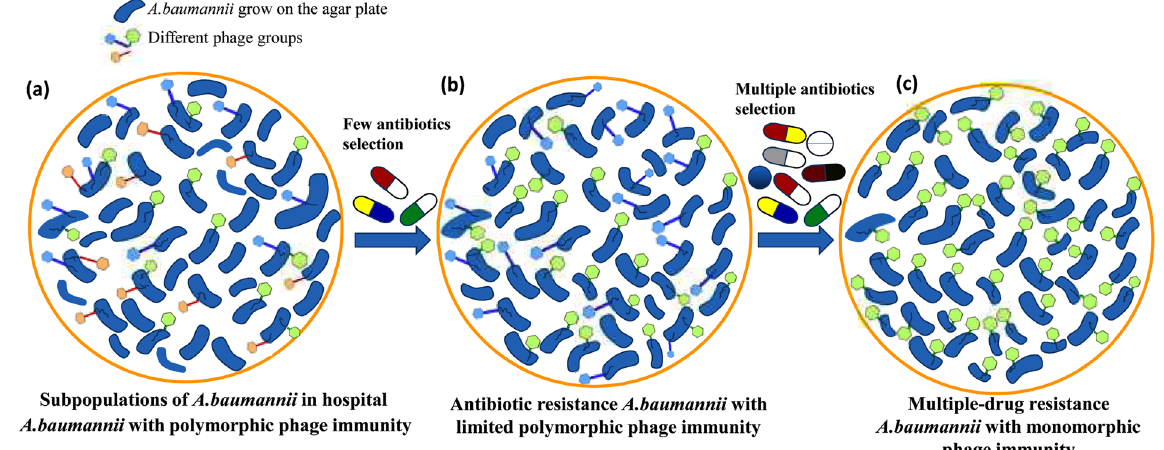
Figure 3. Subpopulations of the clinically isolated A. baumannii strains with different phage immunities: ( a ) strains showing sensitivity to antibiotics demonstrated moderate phage immunity, ( b ) strains showing resistance to a limited number of antibiotics (less than 4) demonstrated moderate phage immunity and (c) stains showing resistance to multiple antibiotics (at least 4) demonstrated low phage